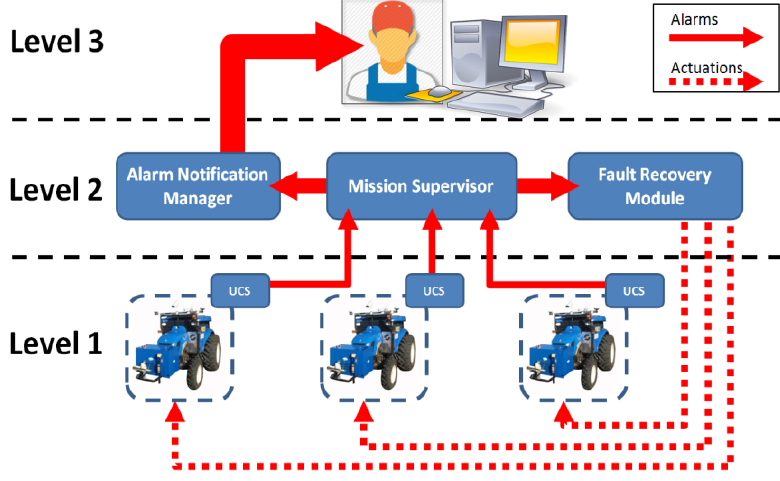
Figure 1. Distributed multi-level